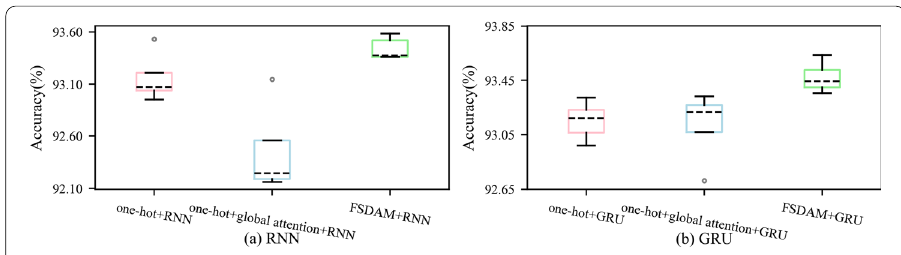
Fig. 11 Comparison results with other existing methods on